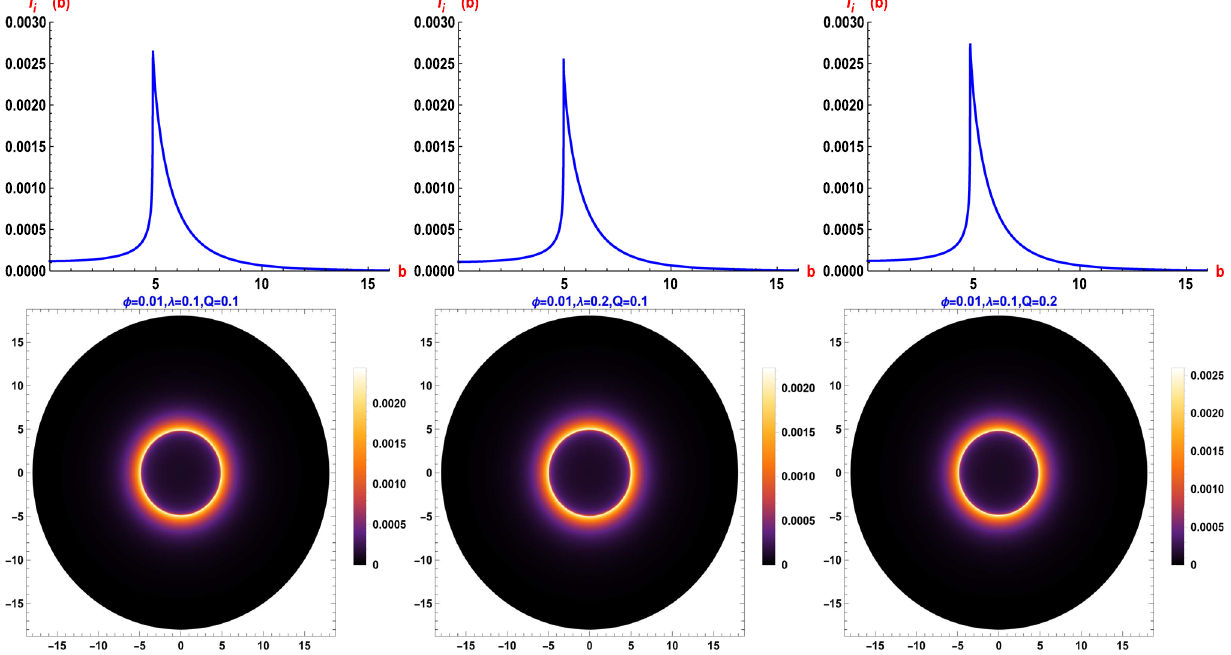
( b ) , cast by a infalling spherical accretion mechanism, under some specific values of BH parameters Fig. 9 Profiles of the specific intensity I obs i as three instant examples with M = 1. The details can be found in the main